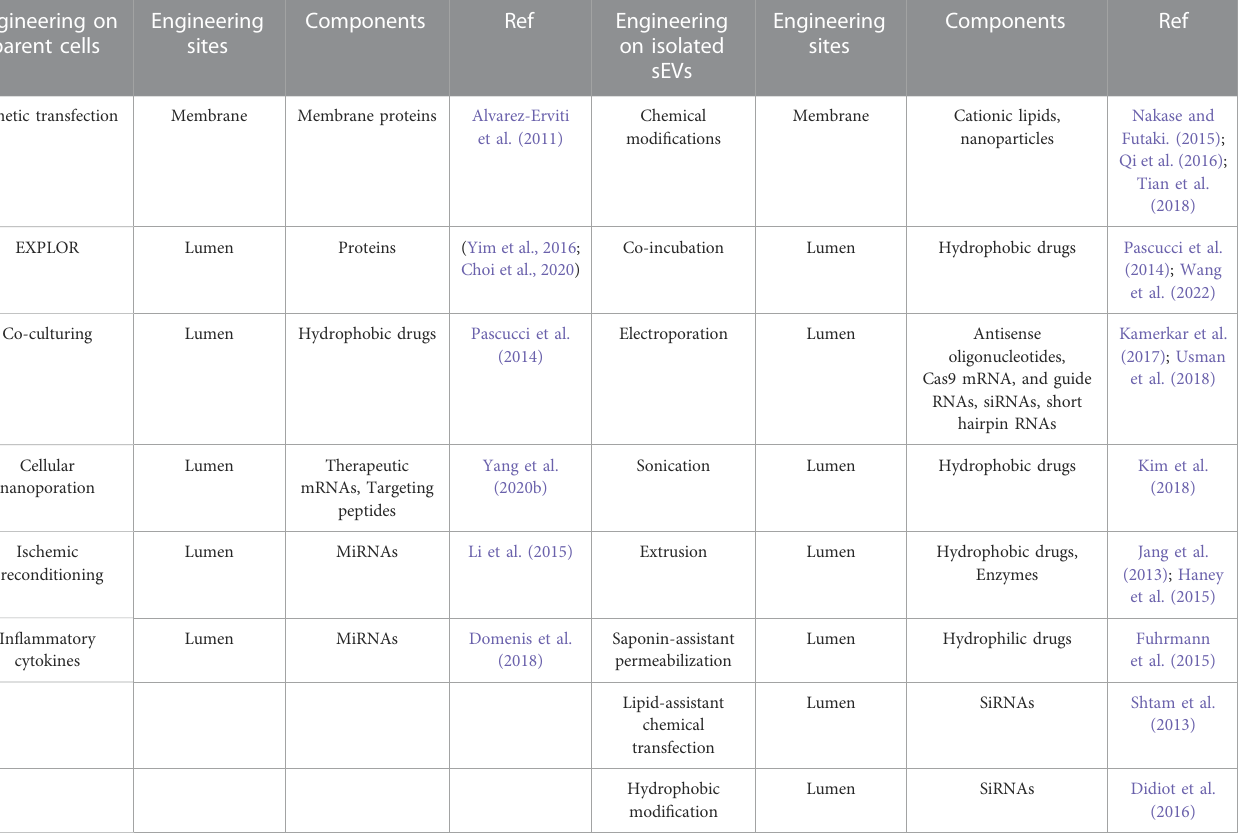
TABLE 8 Current methods for engineering sEVs. Engineering on parent